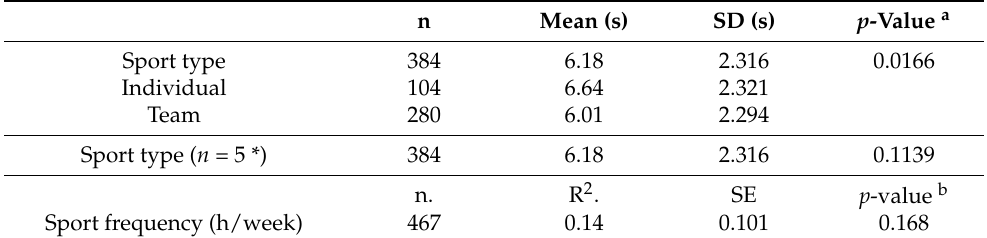
Table 3. Differences in crunning test performances by sport-related aspects. n Mean (s) SD (s) p -Value a